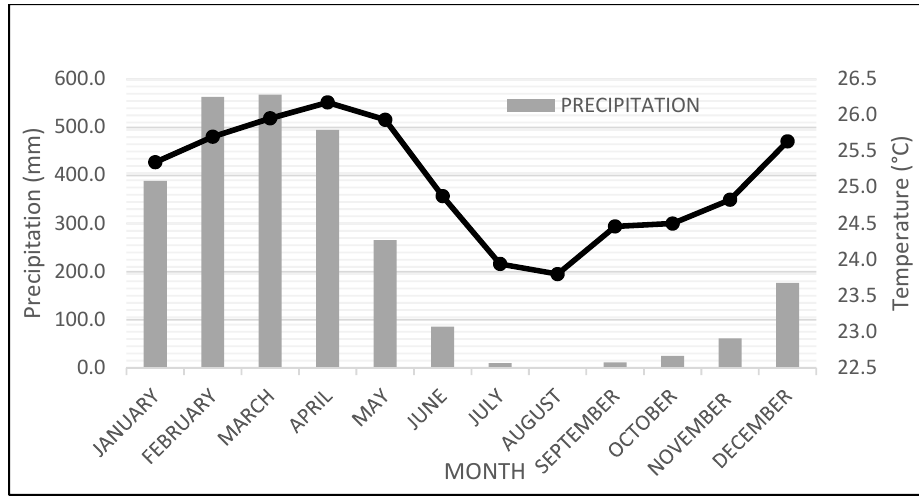
Figure 4. Average monthly precipitation and temperature for the last ten years (2010–2019) in the Quevedo area.